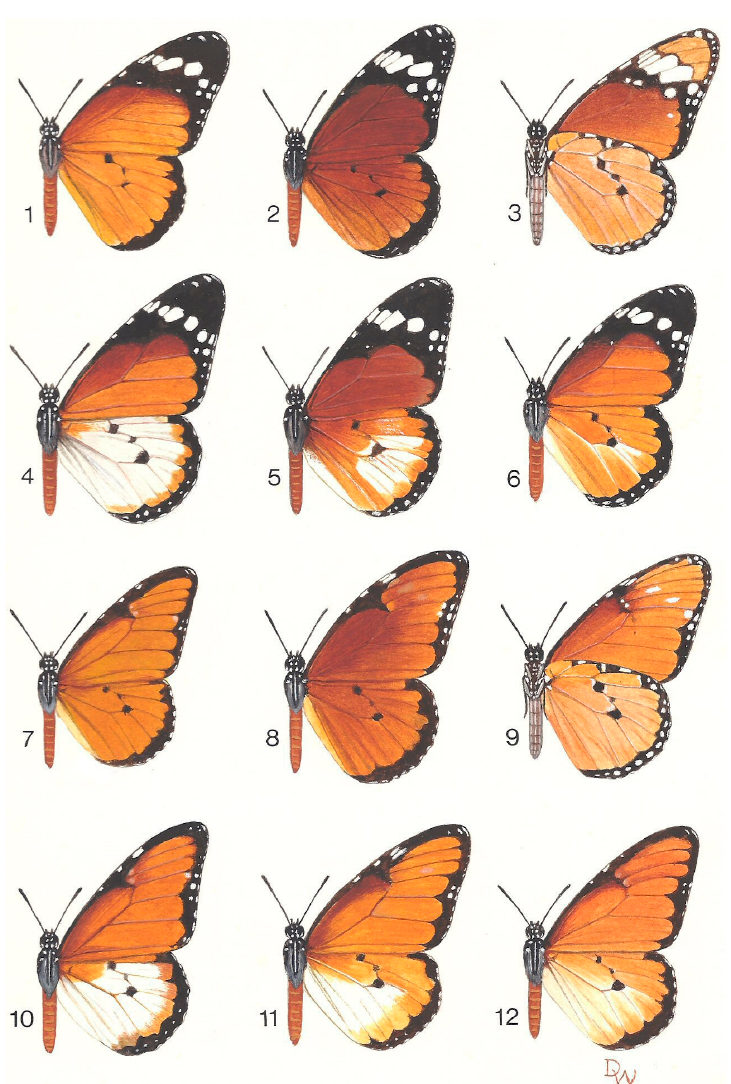
Figure 4. The African subspecies of D. chrysippus , including a range of hybrid forms. 1. D. c. chrysippus ; 2. D. c. orientis ; 3. D. c. orientis (underside); 4. D. c. alcippus ; 5. Hybrid f. alcippoides, F1 from cross 2 × 4; 6. Hybrid f. alcippoides, F1 from cross 1 × 4; 7. D. c. dorippus ; 8. Hybrid f. klugii, F1 from cross 2 × 7; 9. Hybrid f. transiens (underside), F1 from cross 1 × 7; 10. Hybrid f. albinus from backcross 4 × 11; 11–12. Hybrid f. semialbinus, F1 from cross 4 × 7. Courtesy Oxford University Natural History Museum, Hope Department of Entomology. Original painting by the late Derek Whiteley [14].